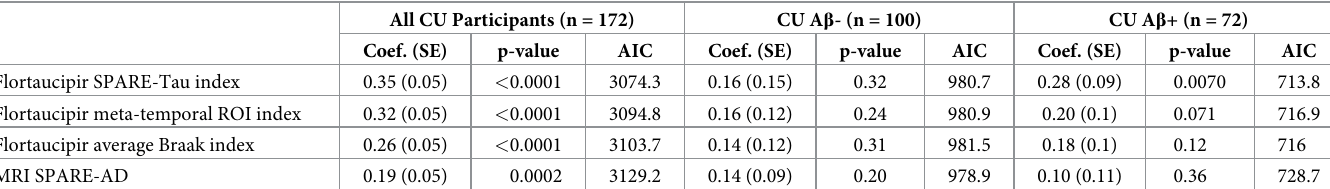
Table 2. Prediction of ADAS-Cog13 longitudinal changes. Analyses adjusted by age, education, and sex. Model with all participants also adjusted for baseline clinical diagnosis. Biomarkers values were classified as normal or pathological to predict cognitive decline. Bonferroni-Holm multiple comparison correction applied. All CU Participants (n =